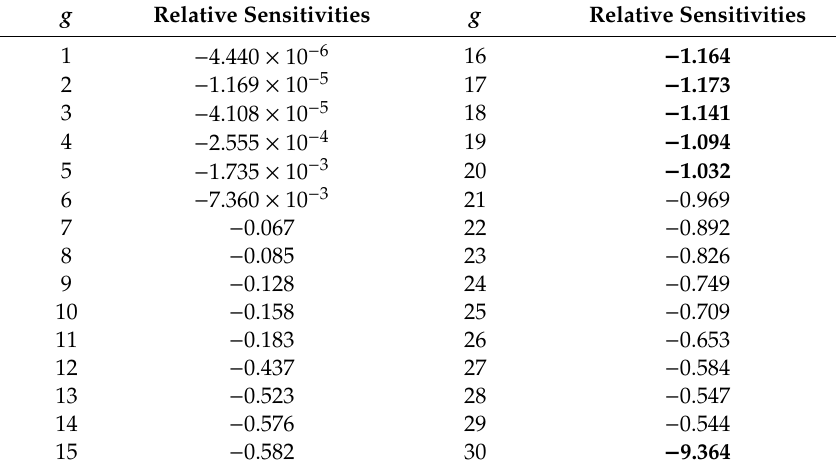
Second-Order Relative Sensitivities S ( 2 ) (cid:17) , g = 1, ... t ,6